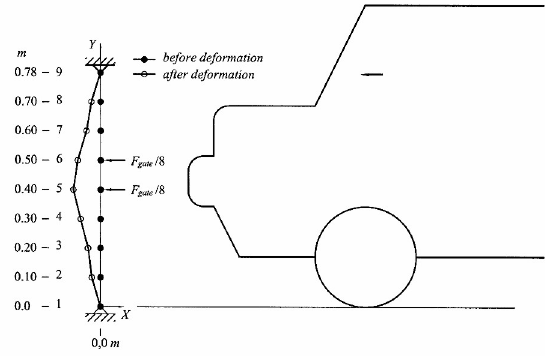
Fig 7. The computational scheme and the outcomes of the computer-run simulation